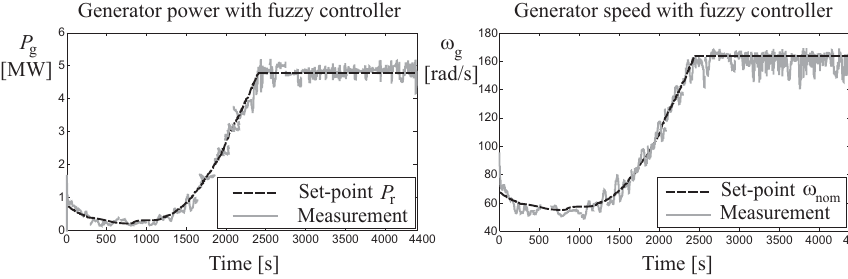
Figure 7. Generator speed ω g and power P g (bold gray line) with respect to their references (dashed black line) ω nom and P r with the fuzzy controllers.